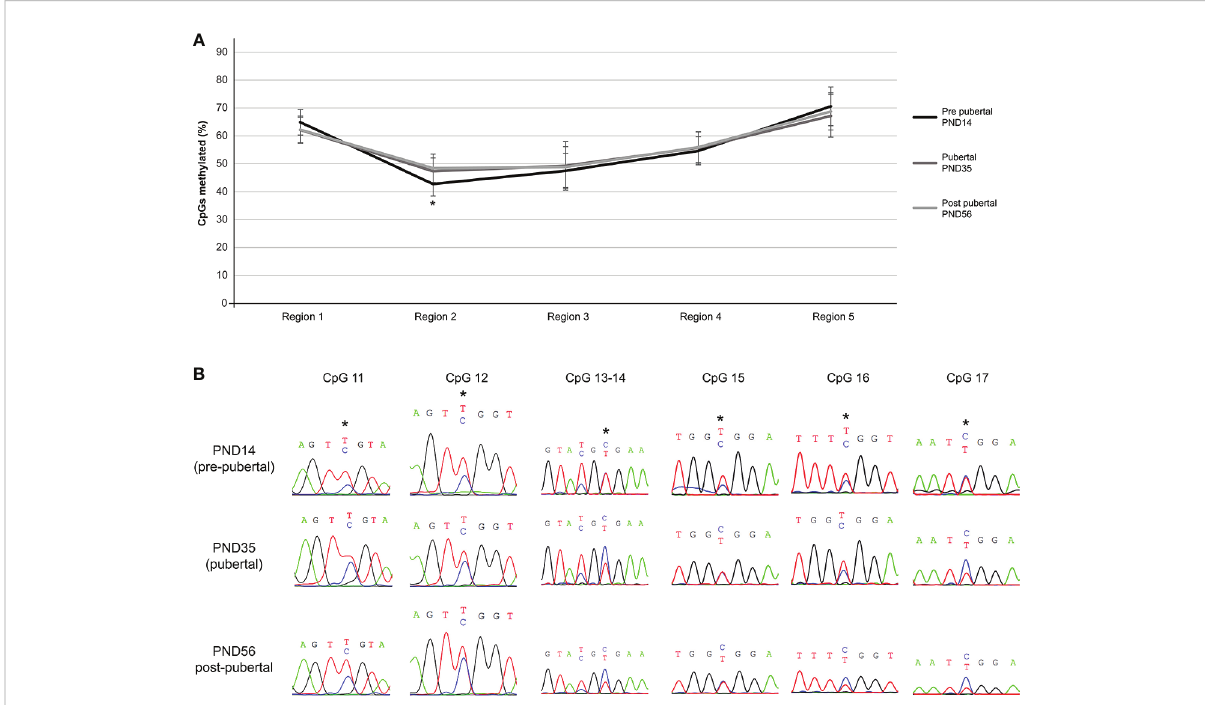
FIGURE 4 Differential methylation of the fi ve regions of the studied Mkrn3 locus. (A) Line graphs showing the percentage of methylated CpGs in the fi ve regions of hypothalamic Mkrn3 locus under study at pre-pubertal, pubertal and post-pubertal developmental stages. *, P=0.0009, one-way analysis of variance (ANOVA). (B) Sequence electropherograms of CpG sites CpG11, CpG12, CpG13, CpG14, CpG15, CpG16 and CpG17 located at the Mkrn3 CpG islet at three developmental stages across puberty. Methylated cytosine residue is depicted in blue color. Asterisks showed the differential methylated nucleotides.